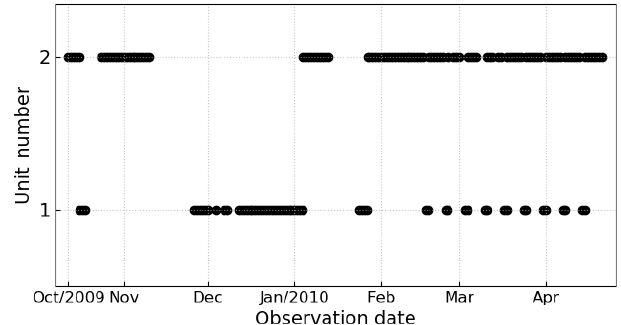
Figure 2. The distribution of AOS unit numbers for the SMILES CH 3 CN observation